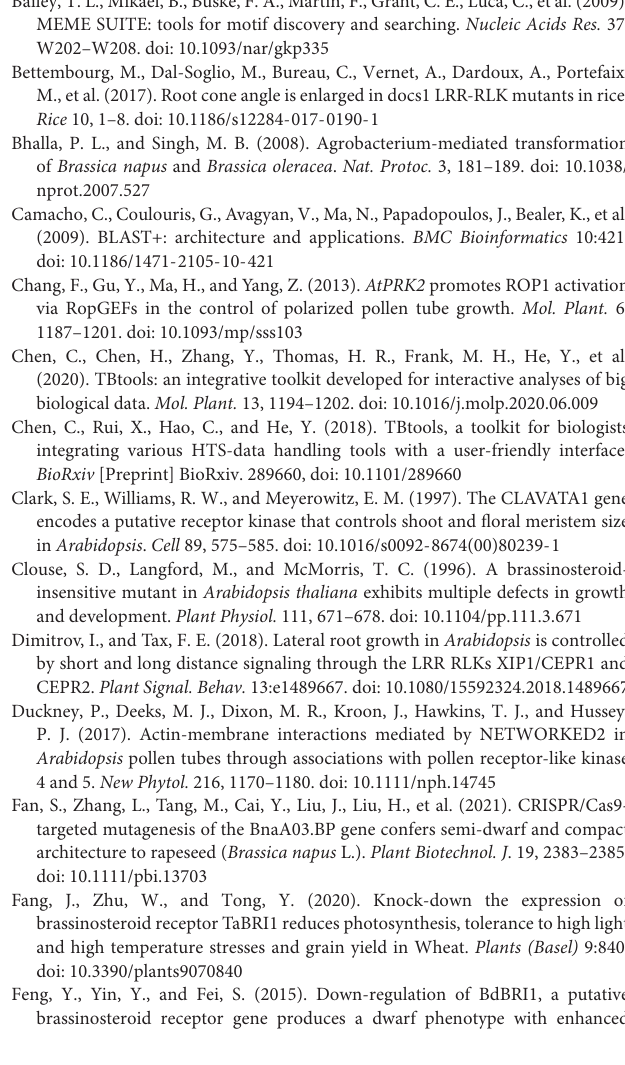
Supplementary Figure 1 | Phylogenetic relationship, conserved motifs and gene structures of BnLRR-RLK proteins. (A) Phylogenetic relationship of BnLRR-RLKs . (B) Conserved motifs of BnLRR-RLKs, boxes of different colors represent different motifs. (C) Gene structure of BnLRR-RLKs. The green and yellow boxes represent the coding sequences (CDSs) and untranslated regions (UTRs), respectively, and black lines represent introns. Supplementary Figure 2 | Chromosomal localization of BnLRR-RLK genes across B. napus chromosomes. Words marked in red indicate tandem duplications. The location of each gene was determined based on its physical location on the chromosome. Supplementary Figure 3 | The synteny of BnLRR-RLK genes in genomes of Arabidopsis and Brassica napus . The light-gray lines represent all collinear blocks between B. napus and A. thaliana , and light-purple lines represent orthologous relationships between BnLRR-RLKs and AtLRR-RLKs . Supplementary Figure 4 | Phenotypes of CRISPR/Cas9 edited BnBRI1 strong mutantats at seedling stage. The bri1 strong mutants showed significant growth retardation with dark green and edge valgus thick leaves, and were eventually lost due to failure to harvest seeds, scale bars, 1.2 cm.